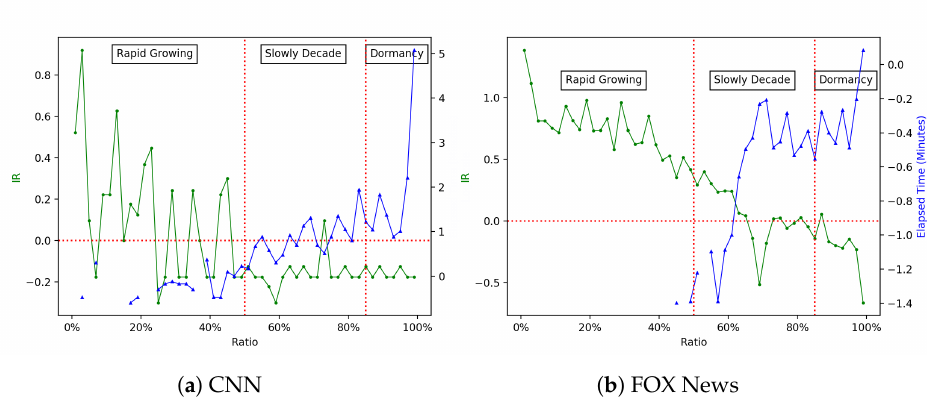
Figure 4. Life cycle of two pages regarding IR and elapsed time.